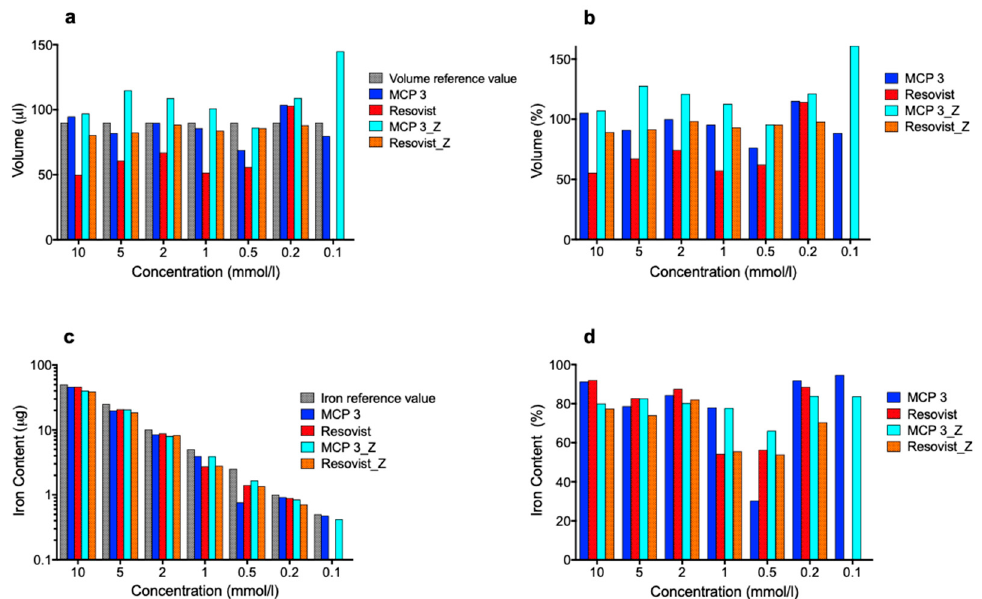
Figure 9. Determination of volume and iron content in the phantom dilution series: volume in absolute terms ( a ) and in relation to the reference volume ( b ), iron content in absolute terms ( c ), and in relation to the absolute iron content ( d ).